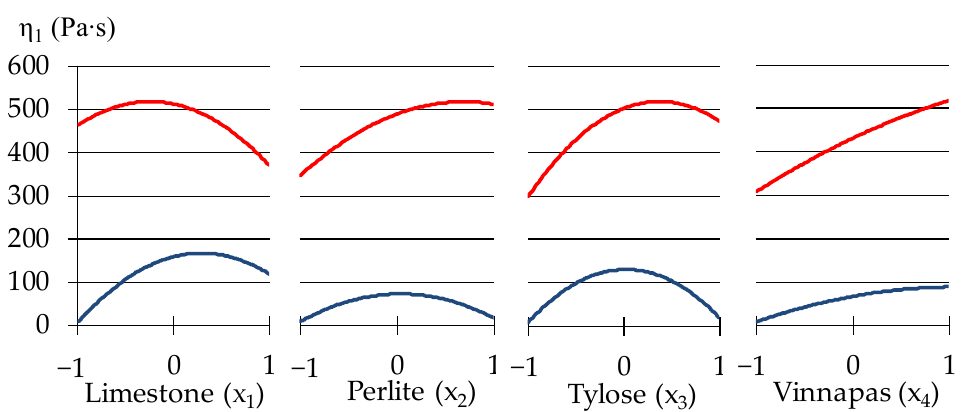
Figure 4. One-factor dependencies of η 1 in zones of its minimum and maximum.